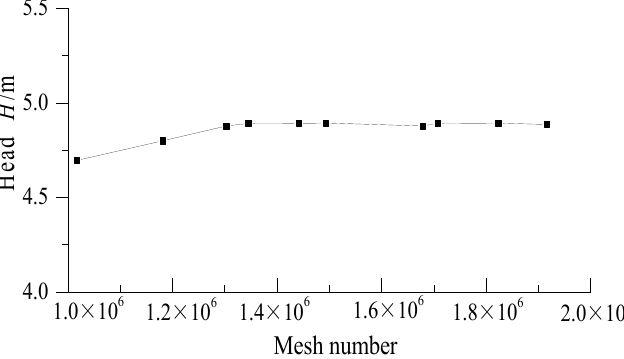
Figure 7. Comparison of the head under different mesh counts.